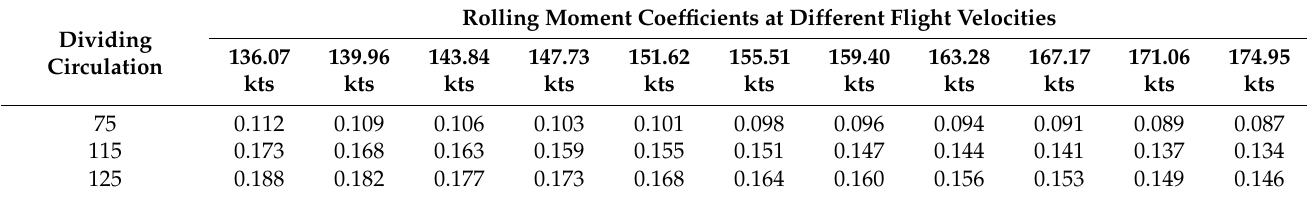
Table 6. The rolling-moment coefficients of CRJ-900 at different